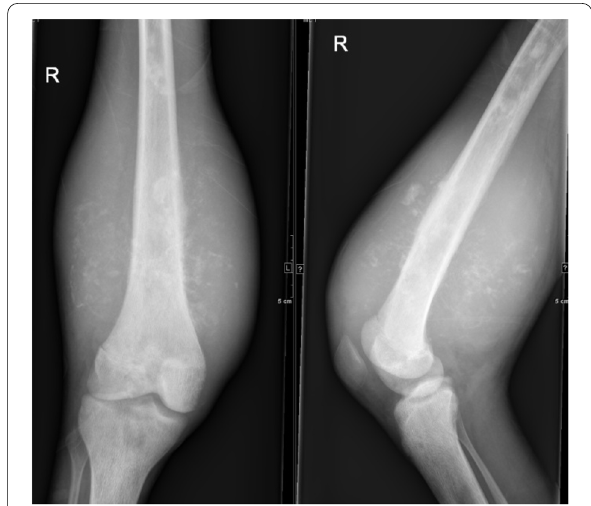
Fig. 7 Mass lesion over mid and distal femur